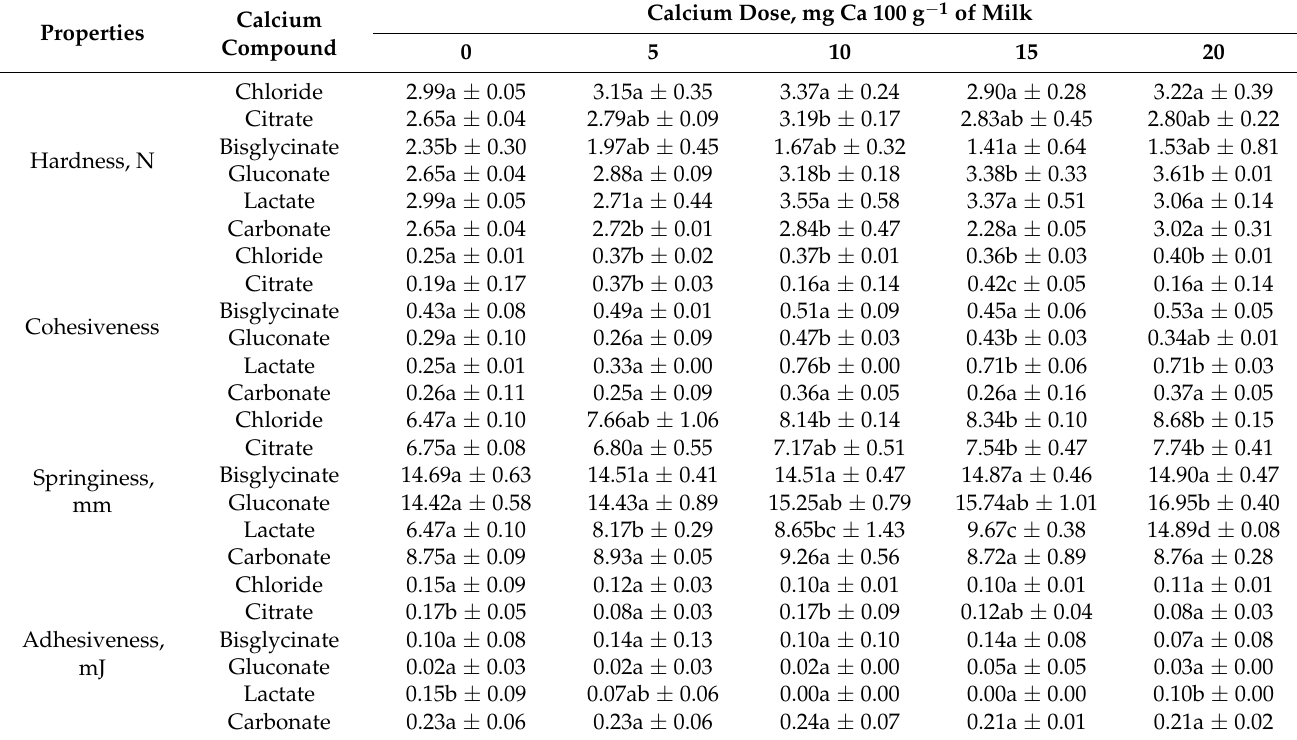
Table 7. Texture parameters of acid rennet goat’s milk